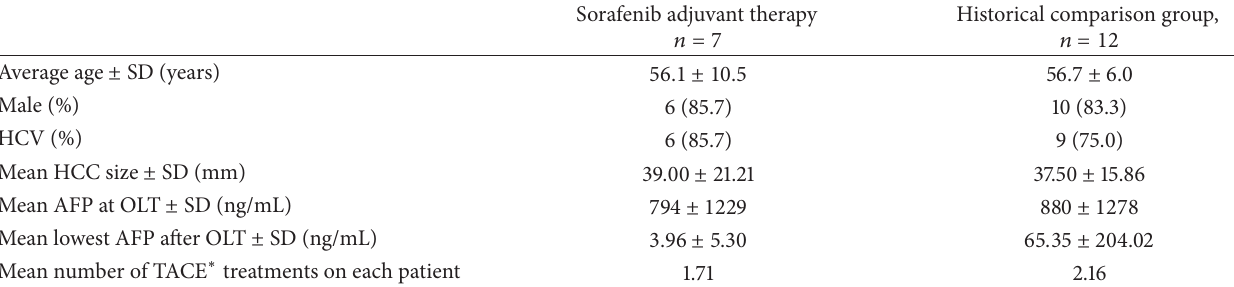
Table 1: Demographic